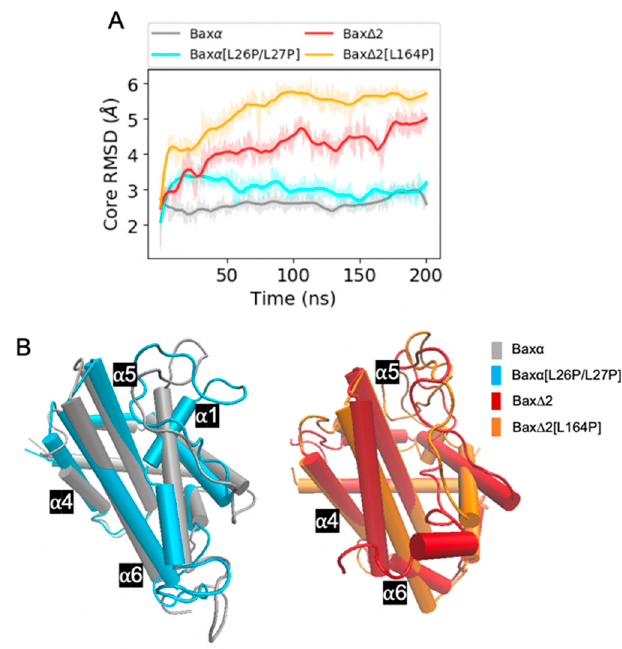
Figure 2. An overview of Bax variant simulations. ( A ) RMSDs of core backbone atoms relative to the initial structure for a period of 200 ns of molecular dynamics (MD) simulations, and ( B ) representative structures selected as described in Section 4.4. Coloring is by variant: Bax α (grey), Bax α [L26P / L27P] (blue), Bax ∆ 2 (red), and Bax ∆ 2 [L164P] (orange). Shaded lines show RMSDs for all recorded points and solid lines are smoothed as described in Section 4.4. Similar plots for two additional repetitions of the simulations are shown in the upper left panels of Figures S2 and S3.